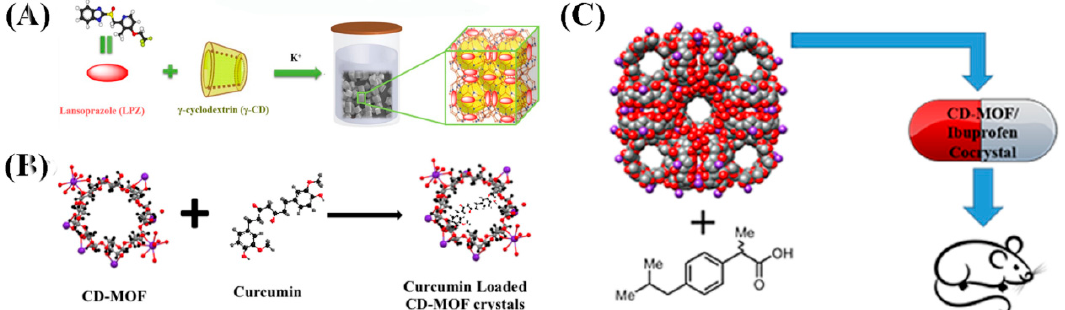
Figure 7. Illustration of CD-MOFs loading drugs. ( A ) Lansoprazole, ( B ) curcumin, and ( C ) ibuprofen loaded by CD-MOFs. Reprinted with permission from [80,88,91], copyright Elsevier, 2017; ACS, 2017; Elsevier, 2016.